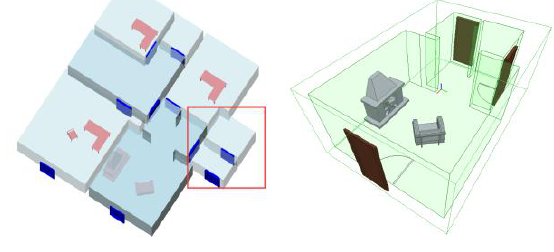
Figure 10. IfcSpace containing furniture